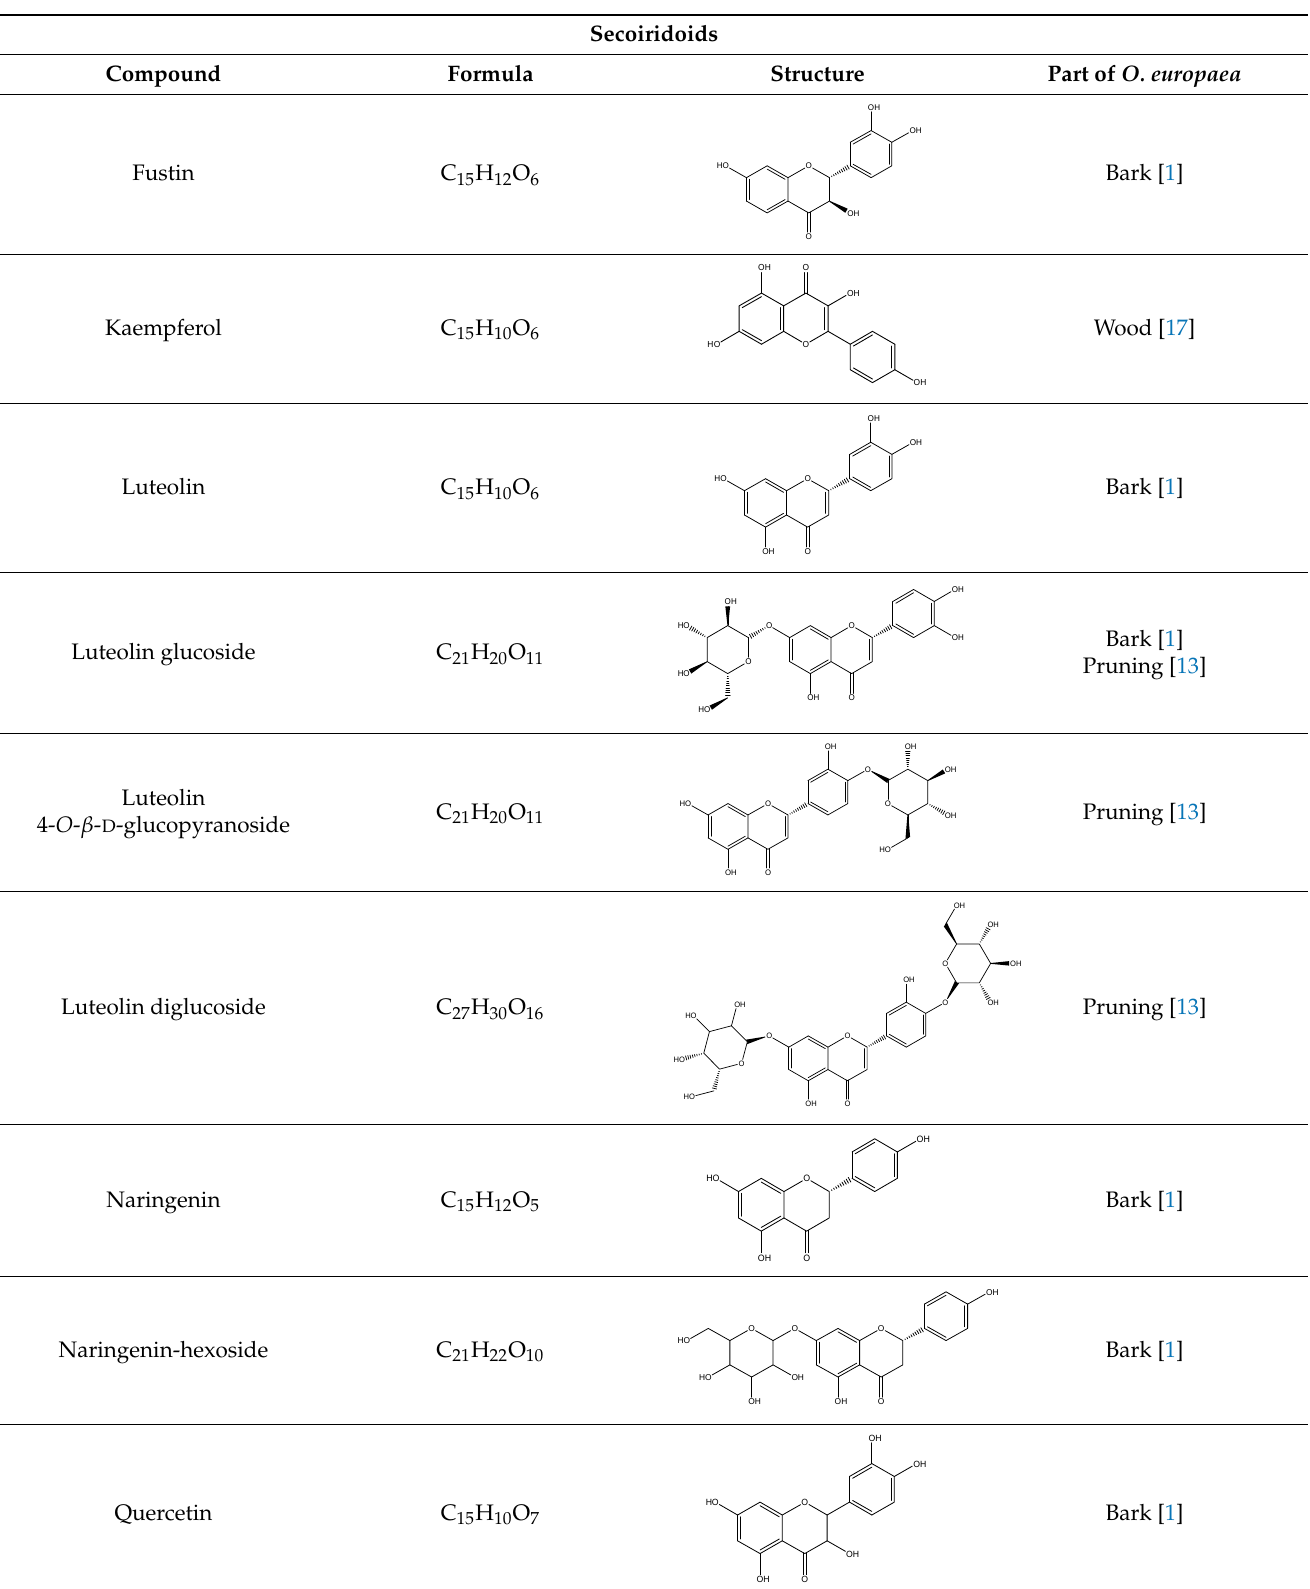
Compound Formula Structure Part of O.